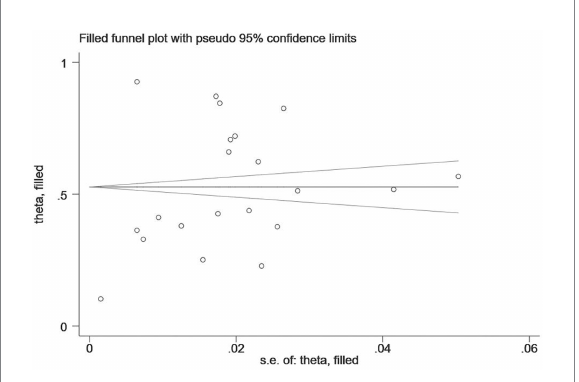
FIGURE 2 A funnel plot assessing publication bias of the prevalence of anxiety among remote learning students during the COVID-19